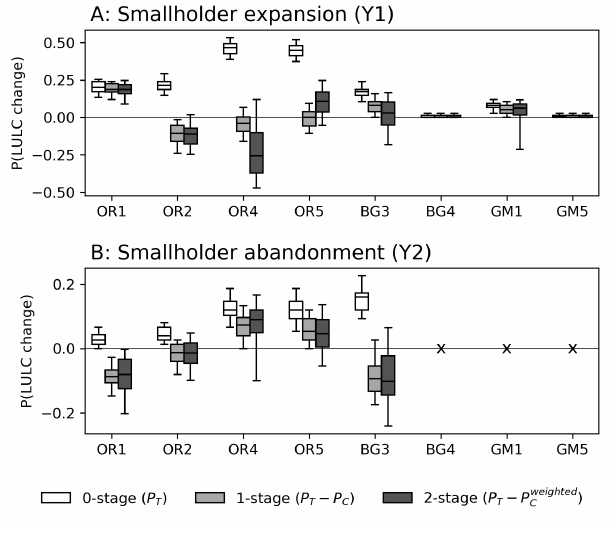
Fig. 5 . Covariate balance at the first stage site selection (A) and the second stage point rebalancing (B and C). The second stage is shown twice because the analysis for each outcome (Y1 and Y2) required sampling points from different areas. BG4, GM1, and GM5 were excluded in the assessment of Y2 because they contained very little smallholder agriculture Pre-LSLT (large- scale land transaction). For this figure, we averaged the absolute standardized mean difference over all covariates. The individual covariates are shown in Appendix 4.